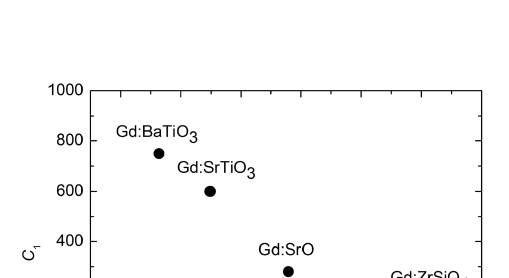
on the ionic radius misfit 1